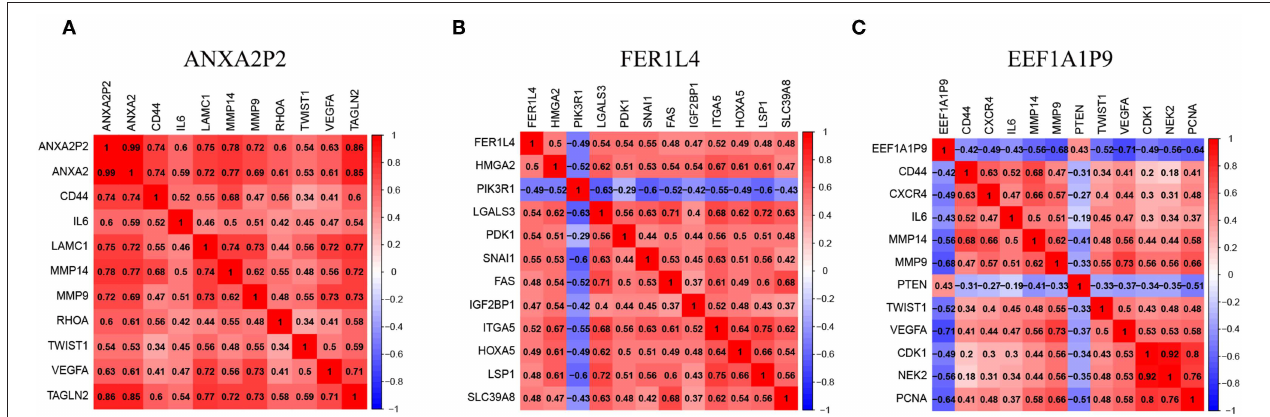
FIGURE 8 | Pseudogenes (ANXA2P2, FER1L4, and EEF1A1P9)-related genes in glioma. (A–C) The heatmaps showed some representative genes highly correlated with the three pseudogenes (| r | ≥